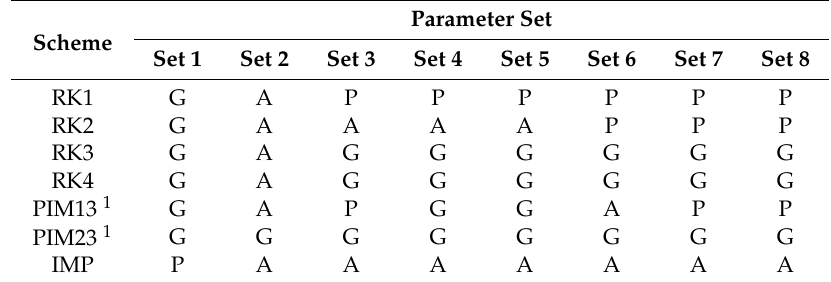
Figure 7. The optimal parameter values and the variations of the mean square error (MSE) values computed by the eight numerical schemes. First row: Normalized optimal parameter values (NPV) for RK1 to RK4; second row: normalized MSE (NMSE) variations for RK1 to RK4; third row: NPV for the Euler schemes; fourth row: normalized MSE (NMSE) variations for the Euler schemes. Table 5. The scheme performances in the DSM optimization with different initial parameter sets. G, A and P stand for “good,” “acceptable” and “poor,”